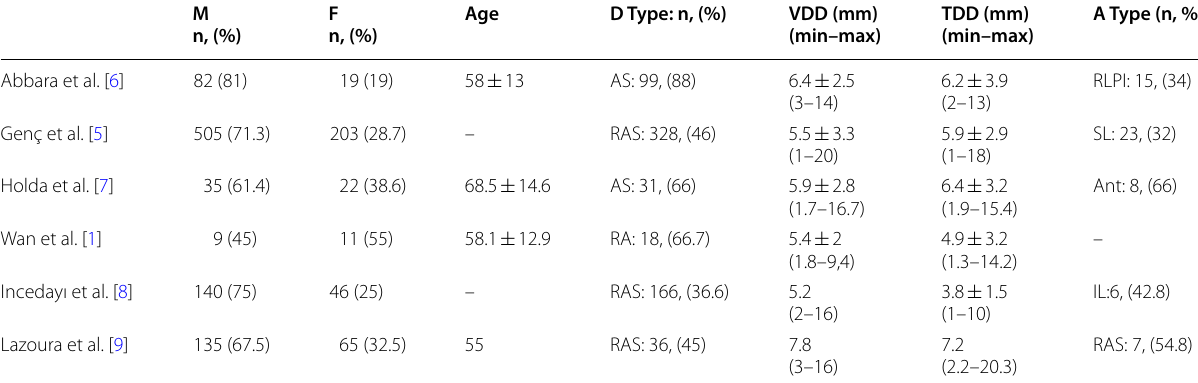
Table 4 Diverticulum and appendage location, diameters, sex–age distribution coexistence of different studies